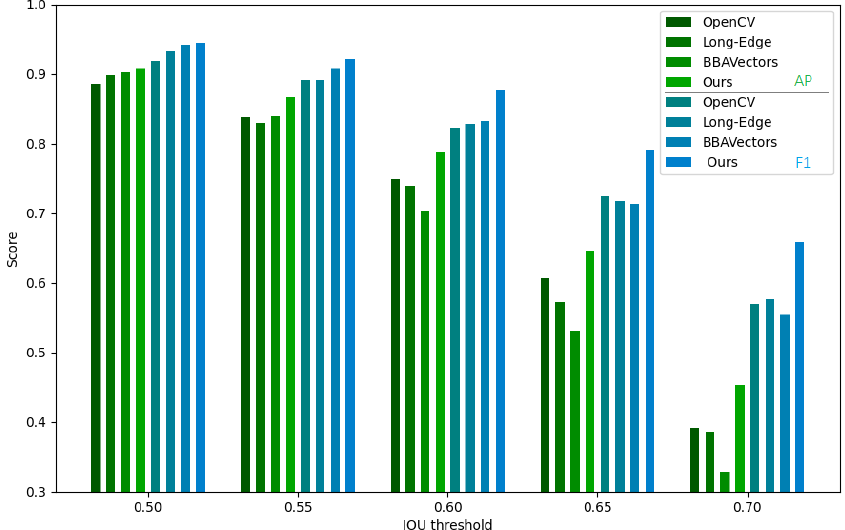
Figure 9. Histogram of the Ap and F 1 score under the different IOU